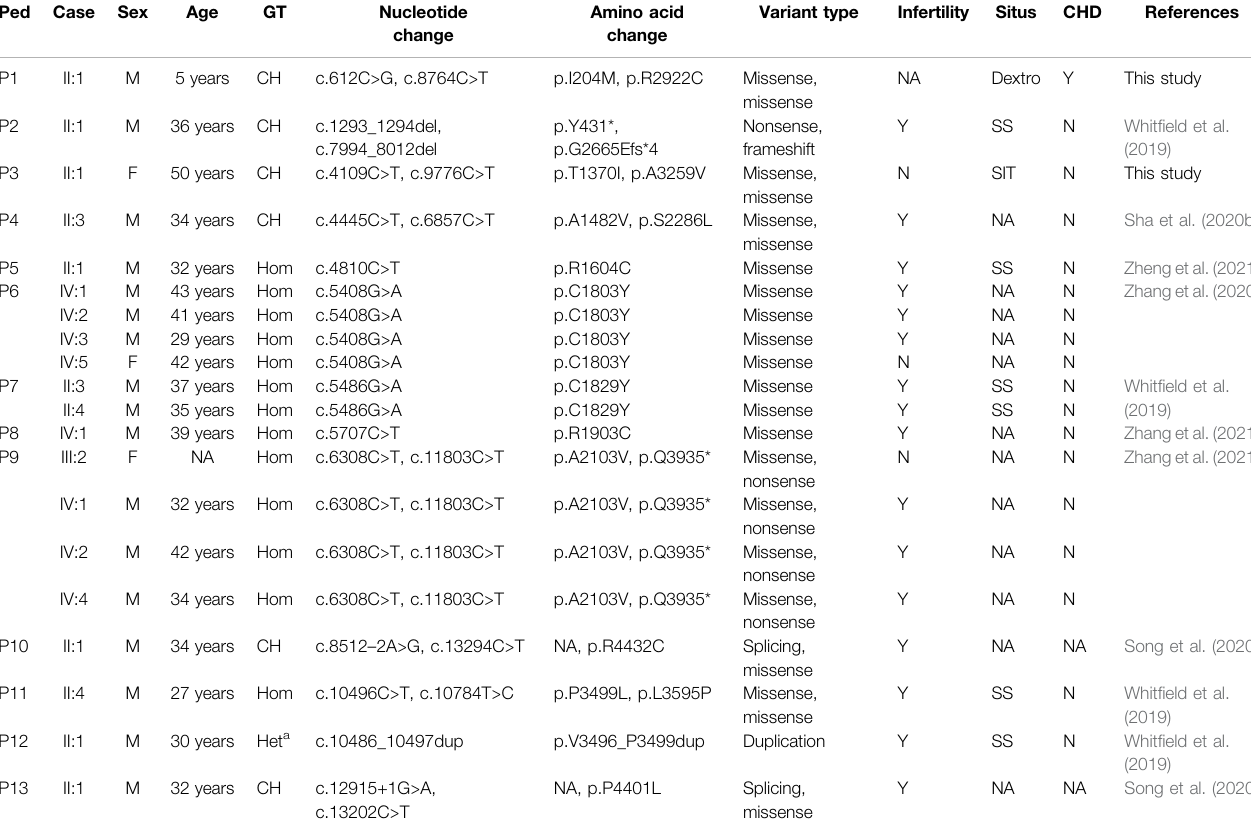
TABLE 3 | Clinical data of the DNAH17 variant carriers in different